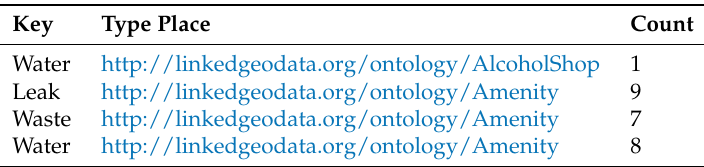
Table 5. Sample of tuples returned by query